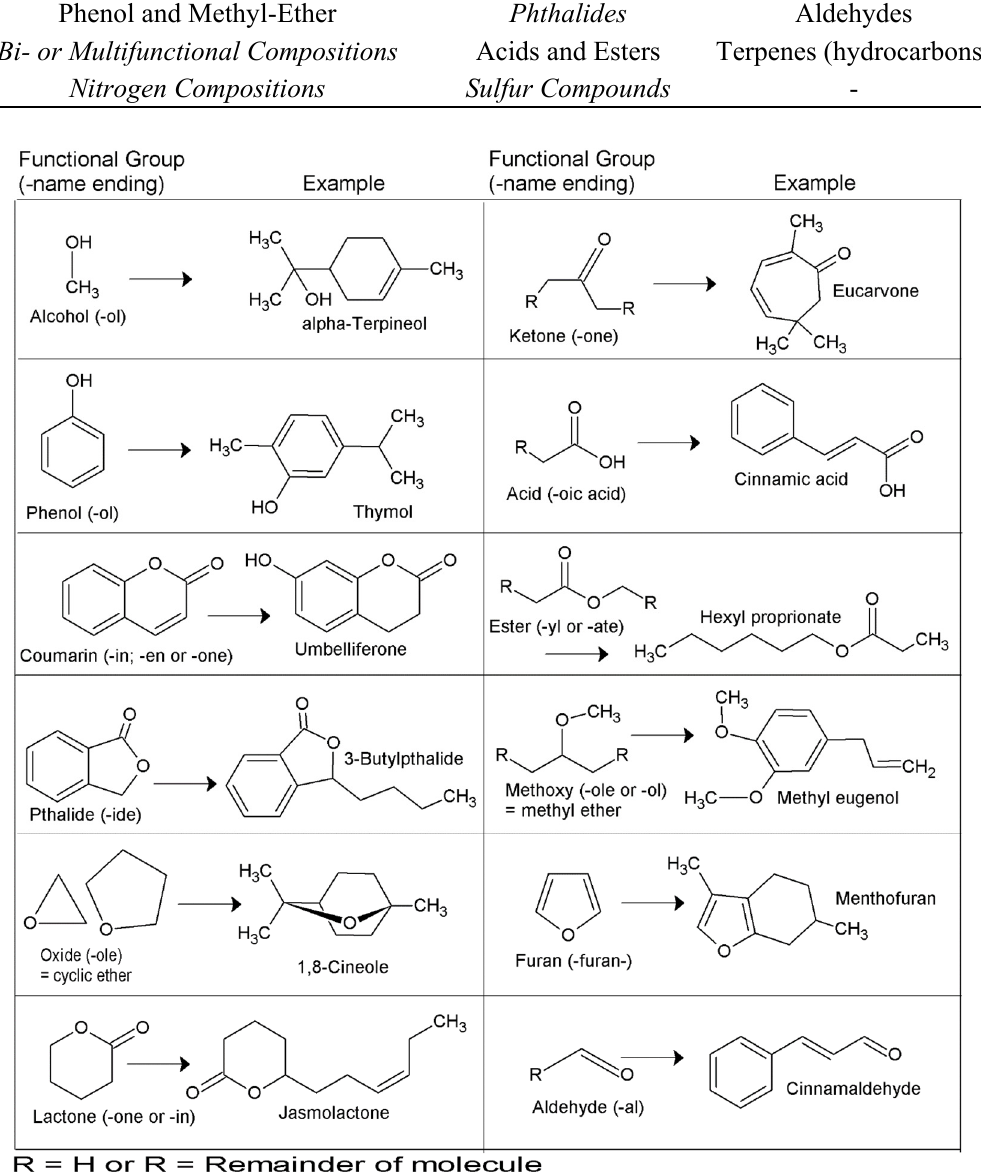
Figure 7. Examples of common functional